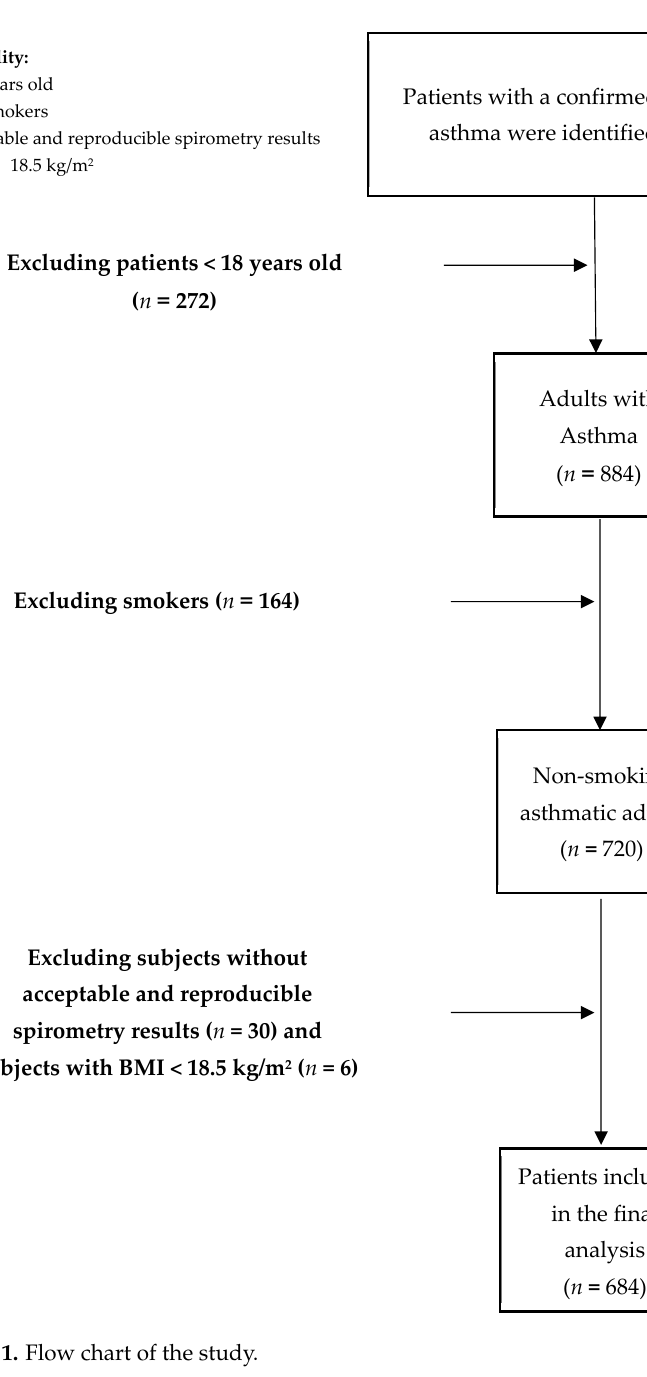
Figure 1. Flow chart of the study.